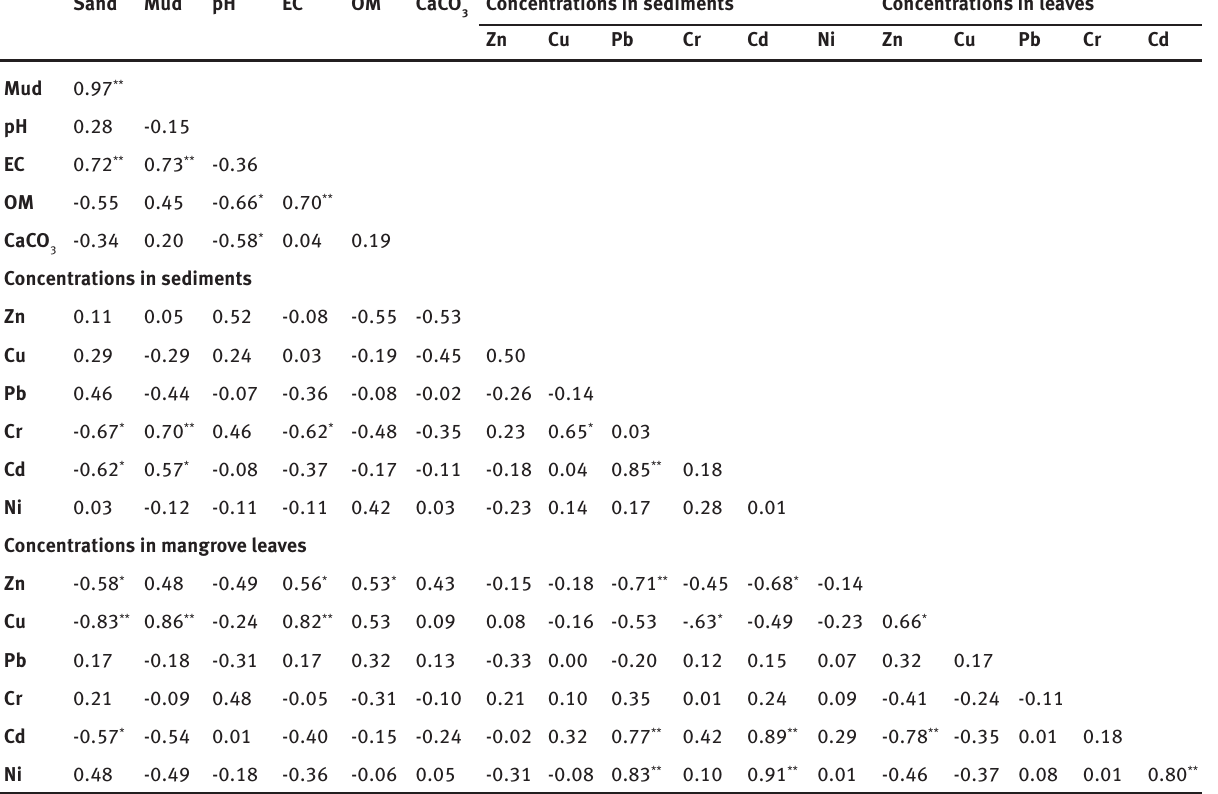
Table 8: Pearson’s correlation coefficients among soil properties and trace elements concentration in the study area.